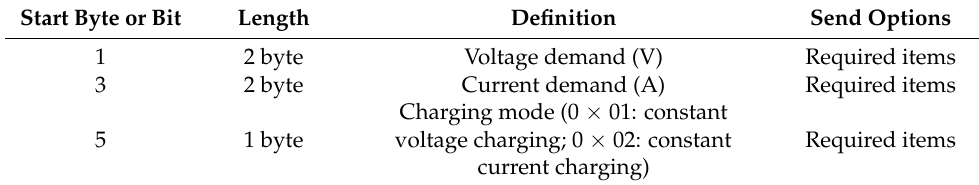
Table 2. Battery charge request message (BCL) information.